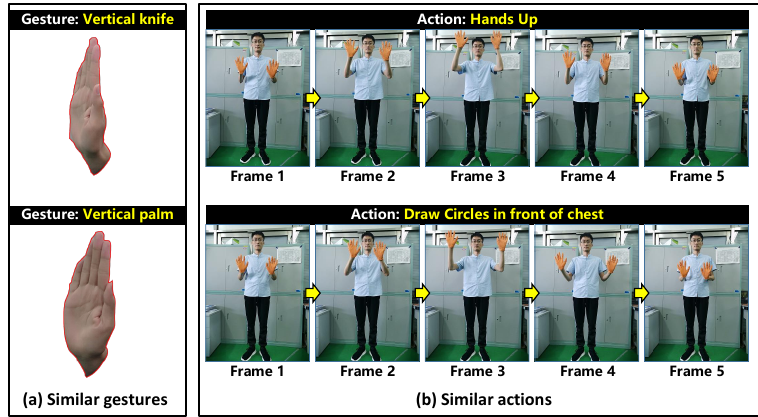
Figure 14. There are some gestures and actions quite similar to each other. In ( a ), two gestures are quite similar, and in ( b ), in five successive images, the human action in four images looks almost the same as others.